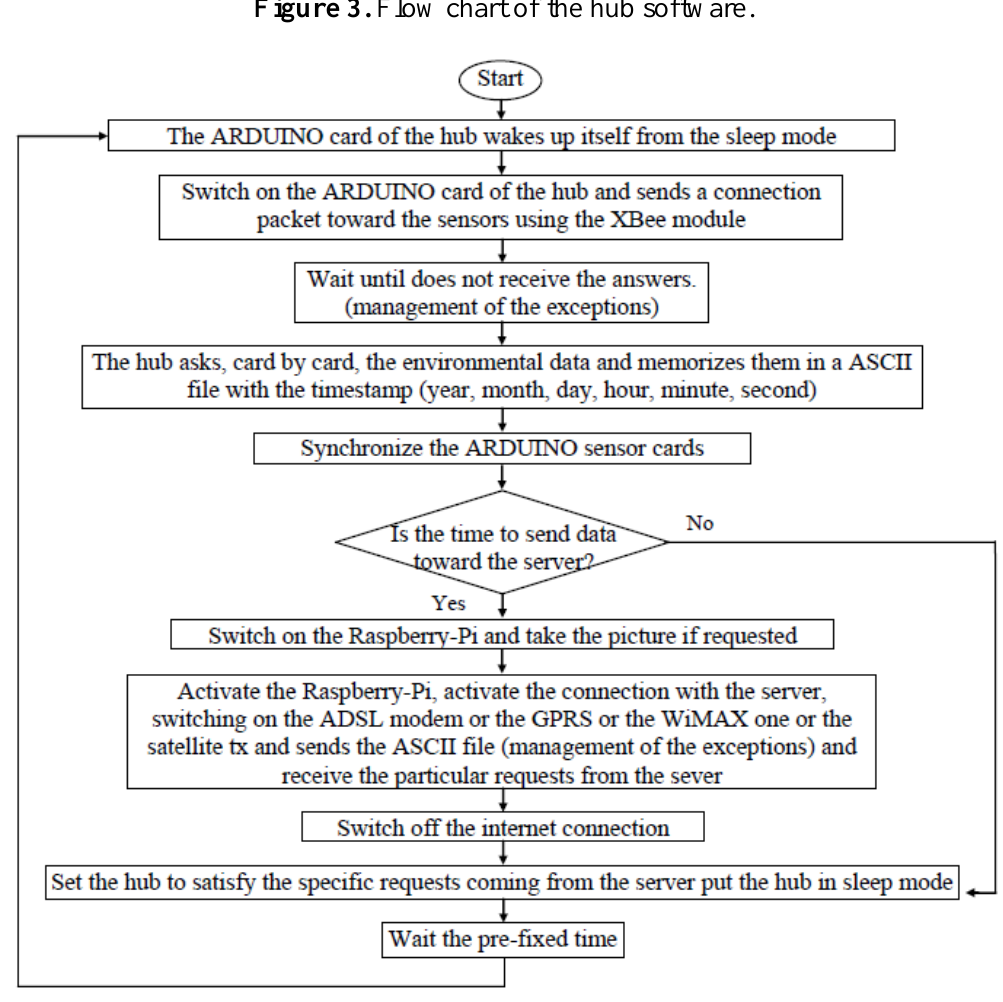
Figure 3. Flow chart of the hub